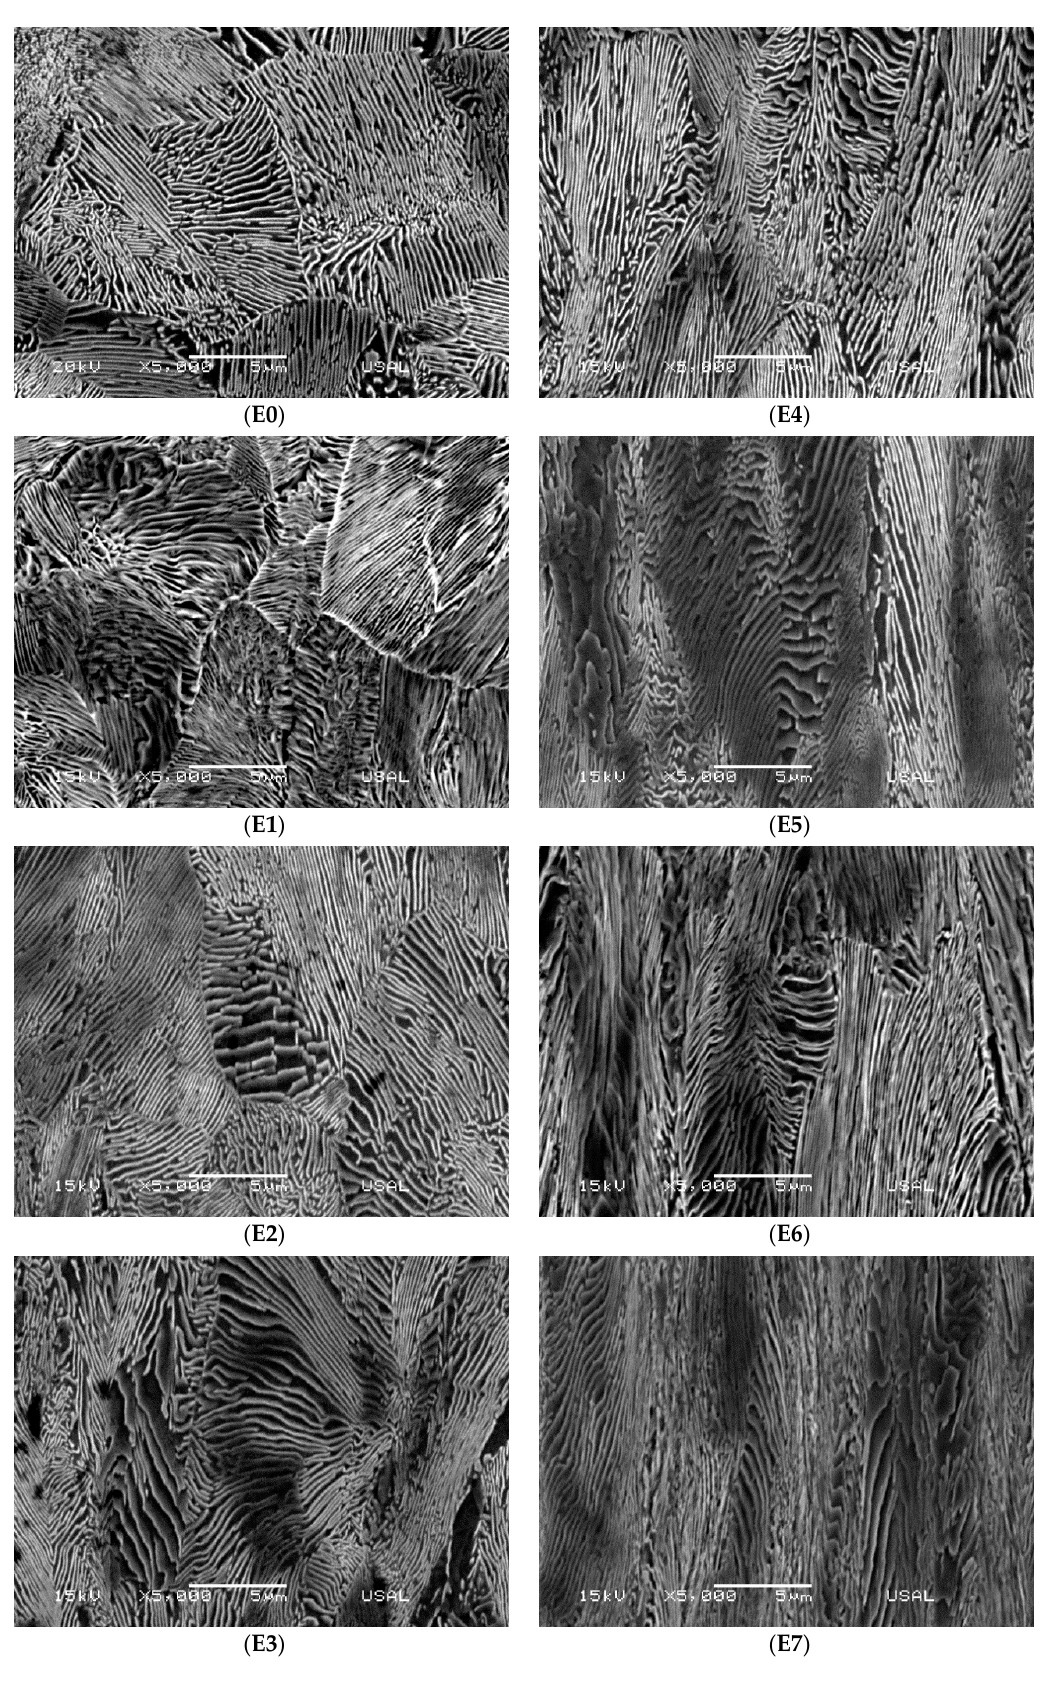
Figure 4. Metallographic analysis of the longitudinal section of family E for diverse drawing steps.